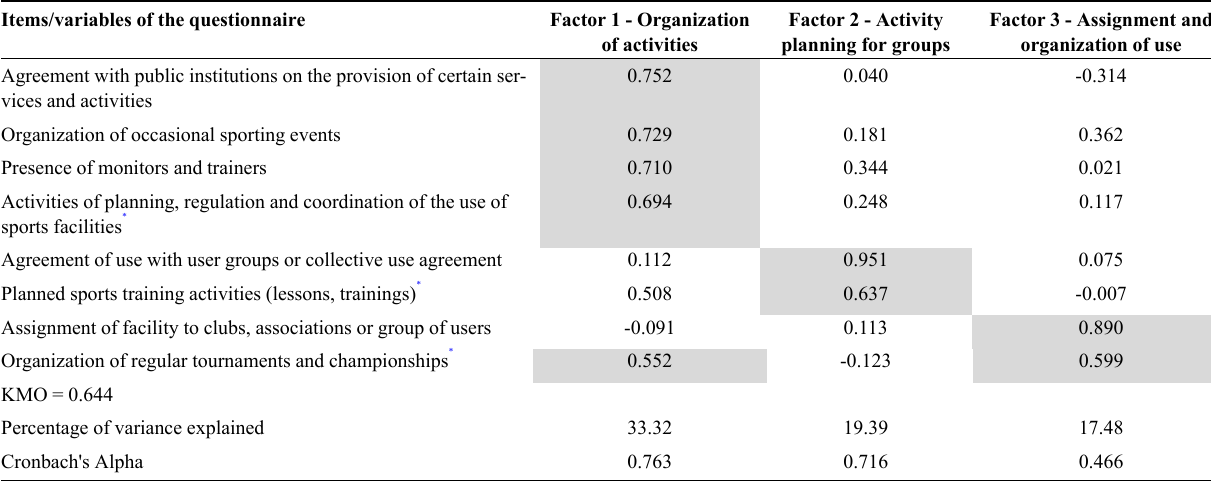
Table 6 - Key components analysis: Supply and Exploration.